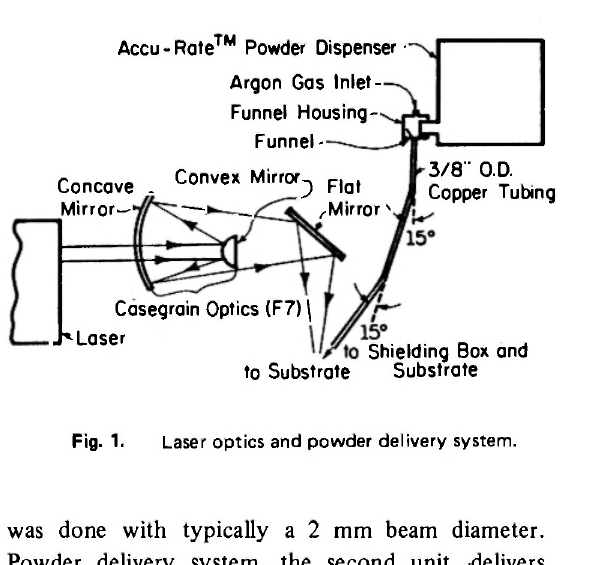
was done with typically a 2 mm beam